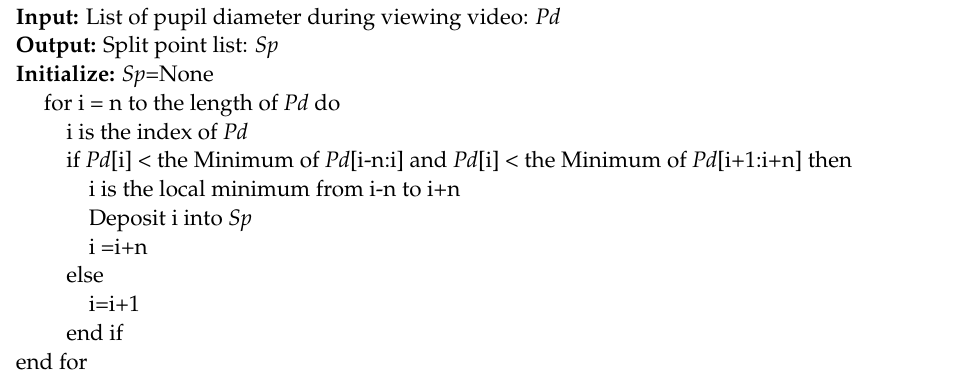
Algorithm 1 Calculating the partition points of the adaptive window